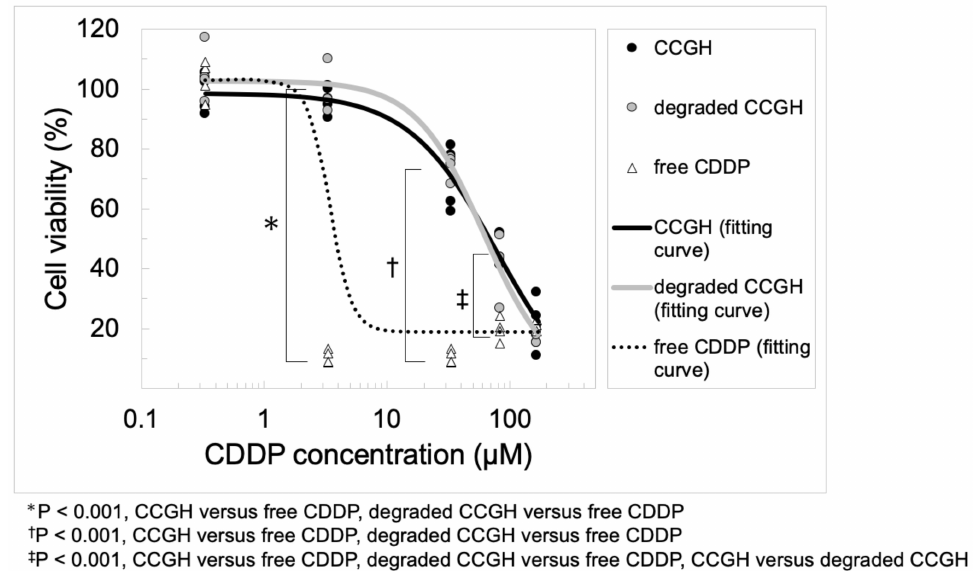
Figure 4. In vitro cytotoxicity of free CDDP solution and CCGH with and without degradation by collagenase. CCGH without degradation by collagenase (black circle), CCGH with degradation by collagenase (gray circle), and free CDDP solution (white triangle) ( n = 4). The line means fitting